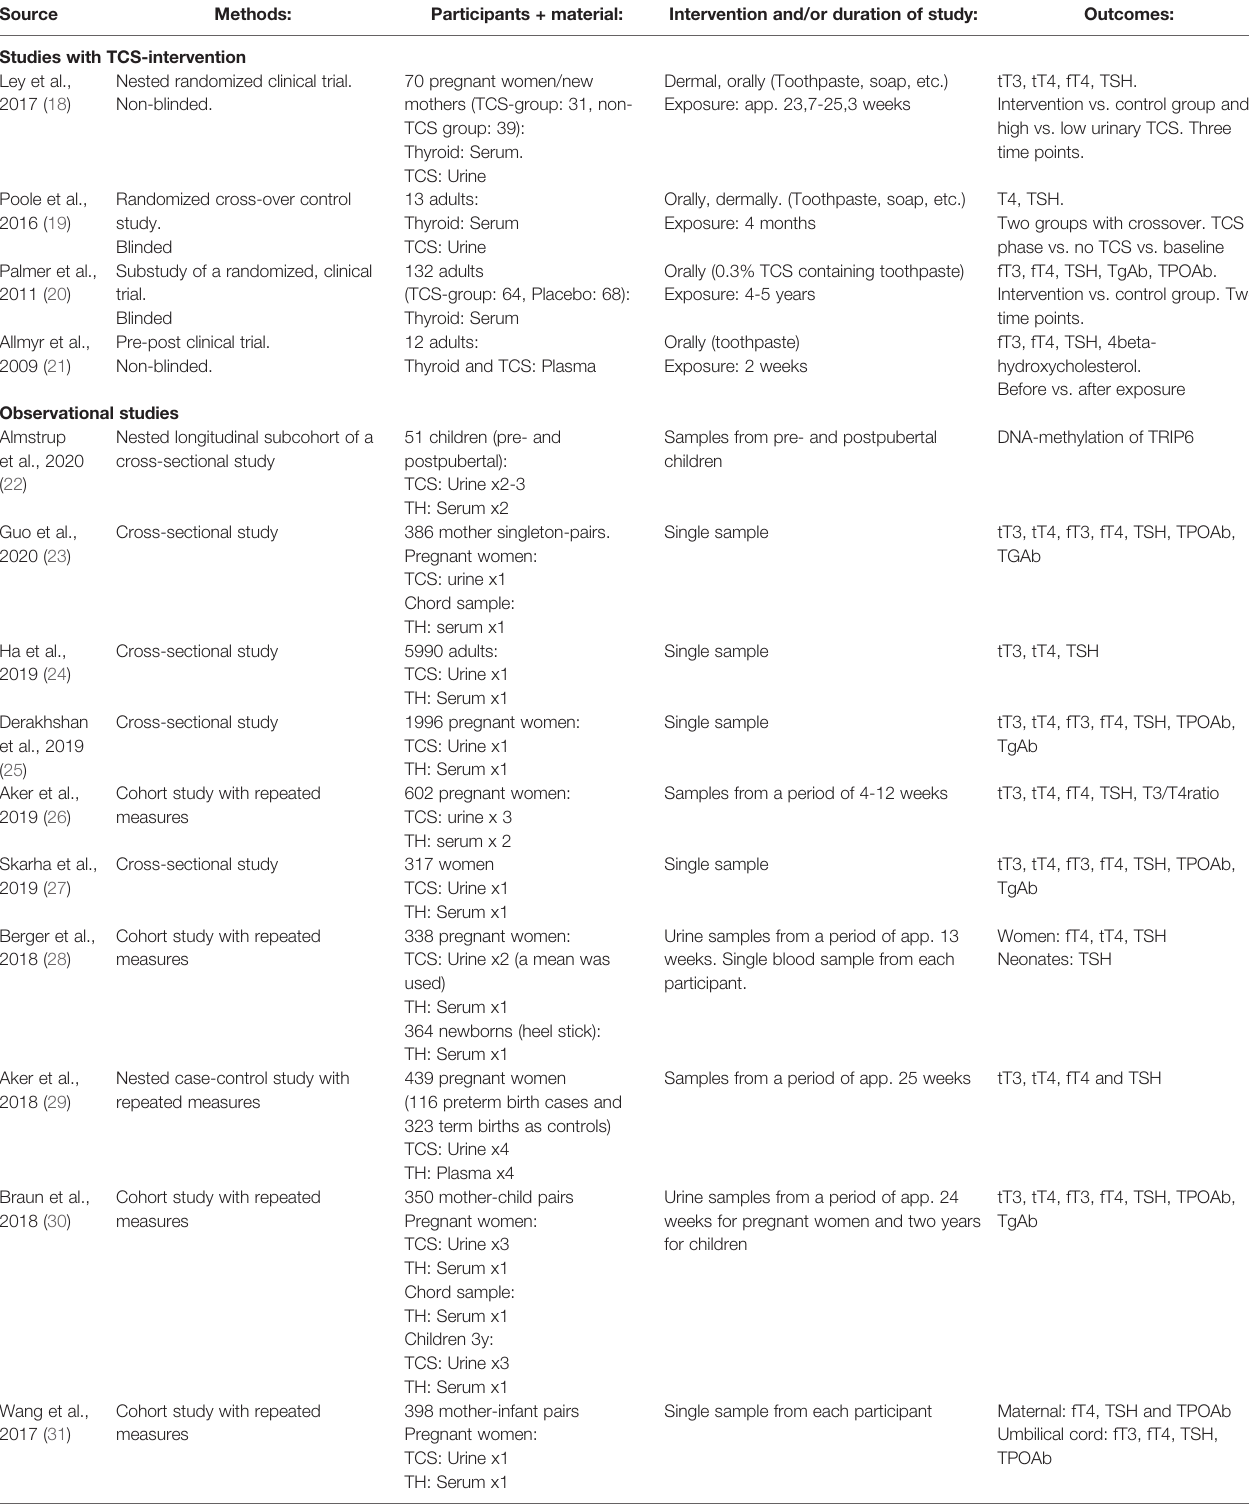
TABLE 1 | Characteristics of the articles (four studies with triclosan intervention and 13 observational studies) obtained from searches at PubMED (1946 to Oct 2020) and Embase (1974 to Oct 2020) of human studies concerning the effect of triclosan on the thyroid hormone system.